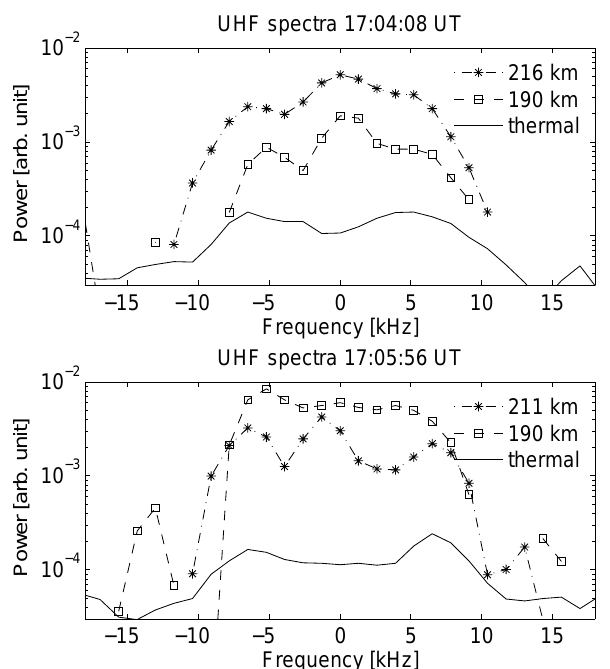
Fig. 3. Radar ion line spectra at 17:04:08 and 17:05:56UT for the upper (dot-dashed line, asterisks) and lower (dashed line, squares) enhancements with 4s integration time. The two solid lines show thermal spectra with integration time of 20s from the altitude region in between the two layers of enhanced backscattered power.